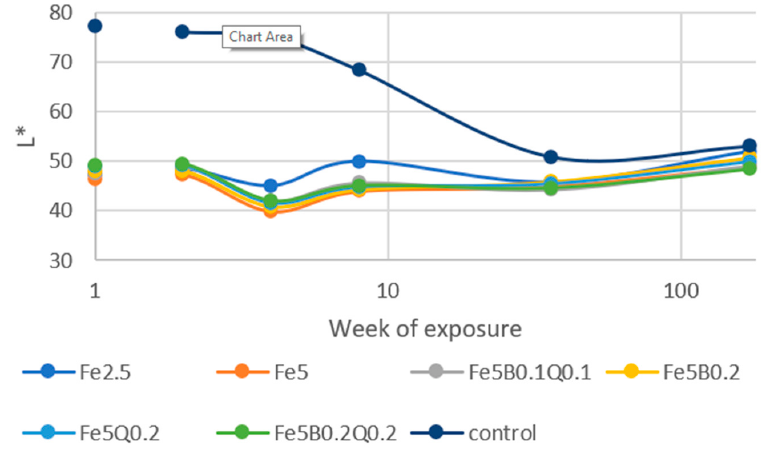
Figure 2. Mean L* values of control and treated Norway spruce samples following outdoor exposure. The compositions of treatments are listed in Table 1. The x -axis is a logarithmic scale.